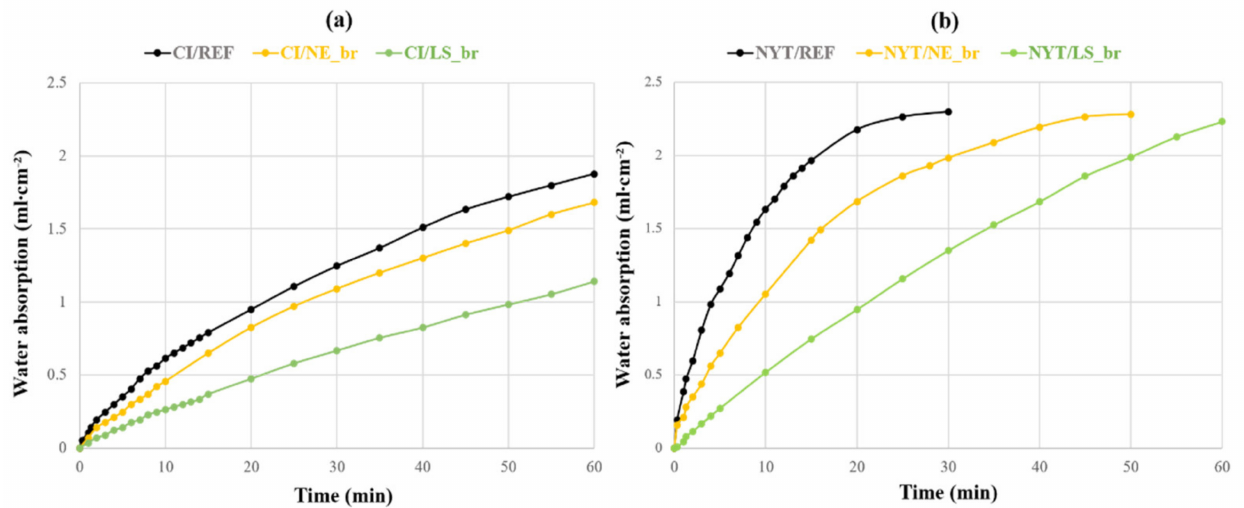
Figure 5. Water absorption by pipe method for ( a ) reference and treated CI samples and ( b ) reference and treated NTY samples.